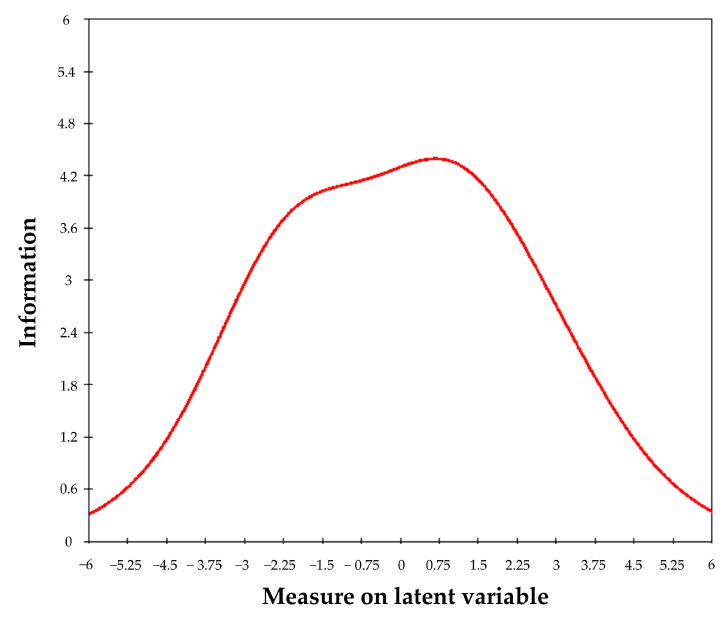
Figure 2. Information function of the CVS-Q IT©.